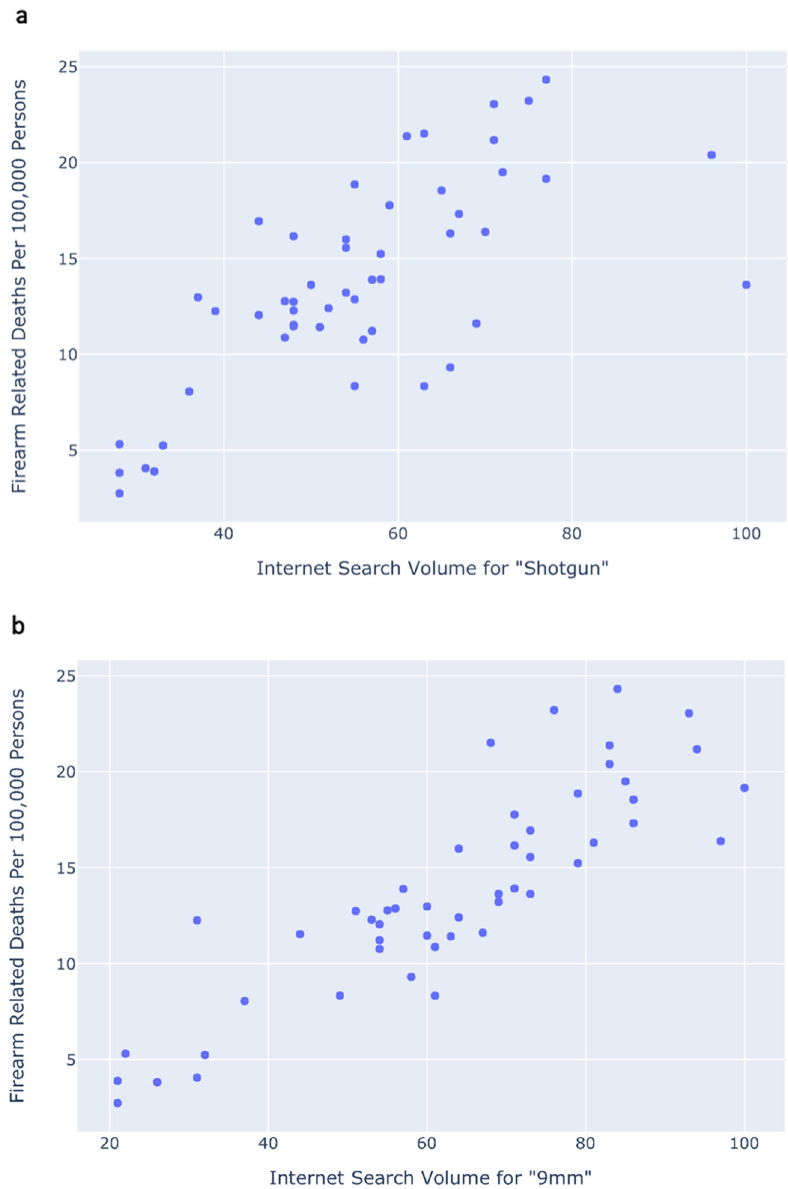
Fig. 4 State-by-state comparisons of fi rearm deaths vs. search volumes. a Firearm-related deaths per 100,000 people vs. relative Internet search volume for shotgun (Pearson ’ s r = 0.71, Spearman ’ s ρ = 0.68). b Firearm-related deaths per 100,000 people vs. relative Internet search volume for 9 mm (Pearson ’ s r = 0.87, Spearman ’ s ρ = 0.90) across all 50 US states in